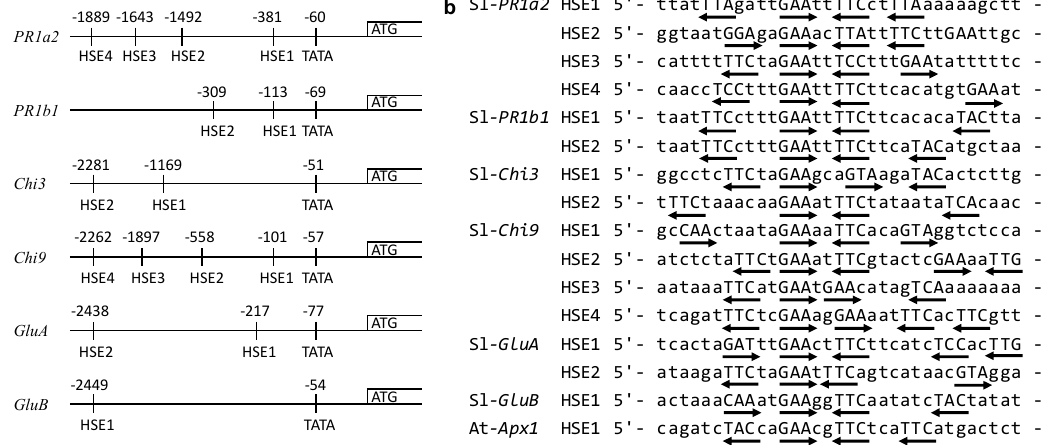
Figure 6. ( a ) The location of possible heat shock elements (HSEs) in tomato PR genes. The numbers indicate the distance (in bp) from the proximal transcription start site (ATG). TATA represents the TATA box consensus sequence. ( b ) Comparison of the HSE from tomato PR genes (Sl-) and Arabidopsis apx1 (At-). Sequences matching the nGAAn, the basic 5 bp HSE motif are indicated in uppercase letters. Orientation of the nGAAn-like motifs are indicated by arrows.